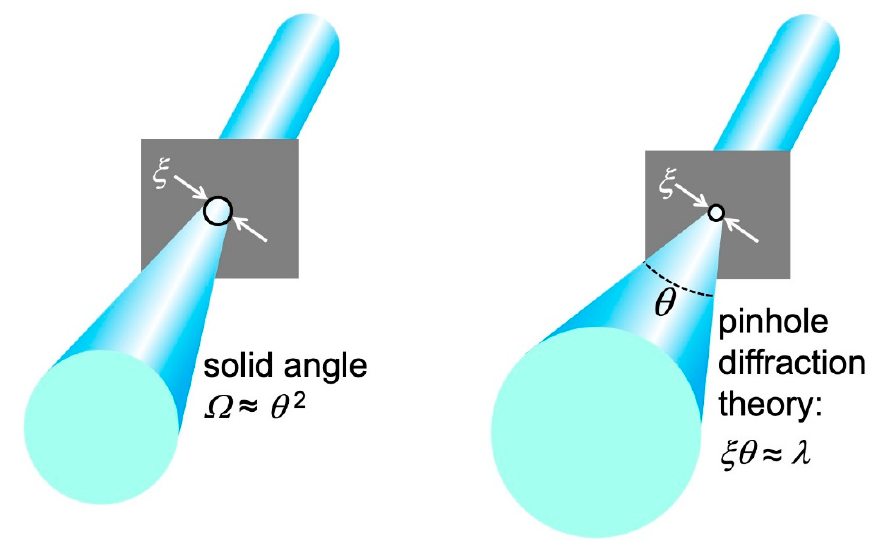
Figure 18. An attempt to obtain a small-area source using a shield with a pinhole reveals the diffraction limit for “lateral coherence”.